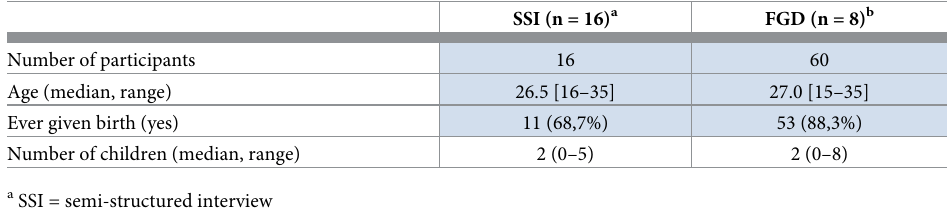
Table 1. Sociodemographic characteristics of the